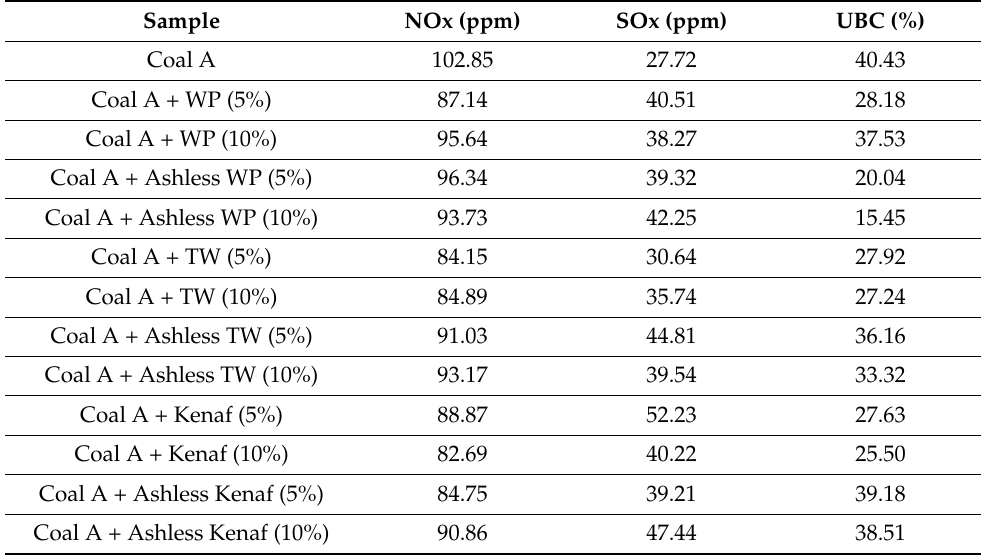
Table 3. Summary of the gas and UBC concentration in different sample